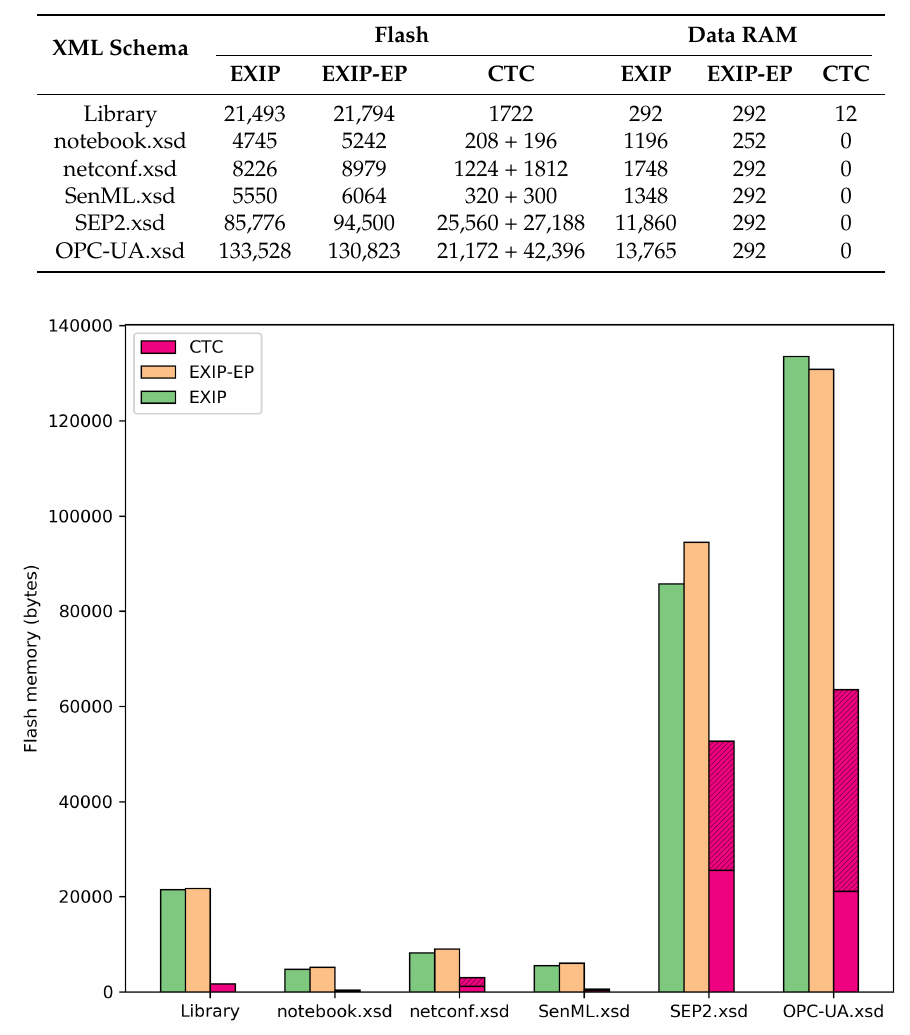
Table 5. Memory consumption comparative in bytes. The table shows the use of code memory (Flash) and data memory (RAM). Additionally, the maximum heap and stack used for the EXIP case is 1734 and 904 bytes respectively. For the EXIP-EP case, maximum heap and stack usage amounts to 1294 and 792 bytes respectively. Finally, CTC uses no Heap and the maximum stack size used for the tests is 692 bytes.